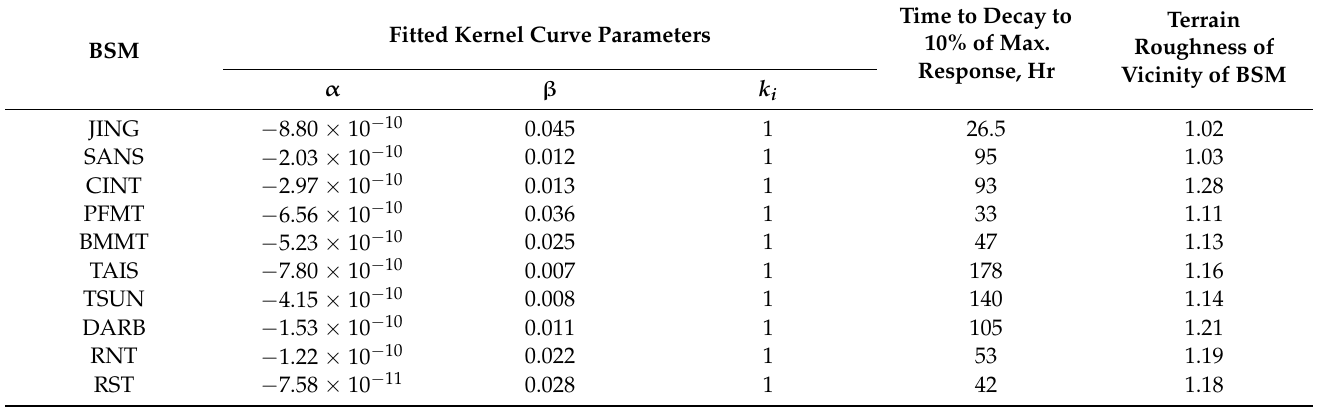
Table 2. Coefficient of the kernel fitting function.